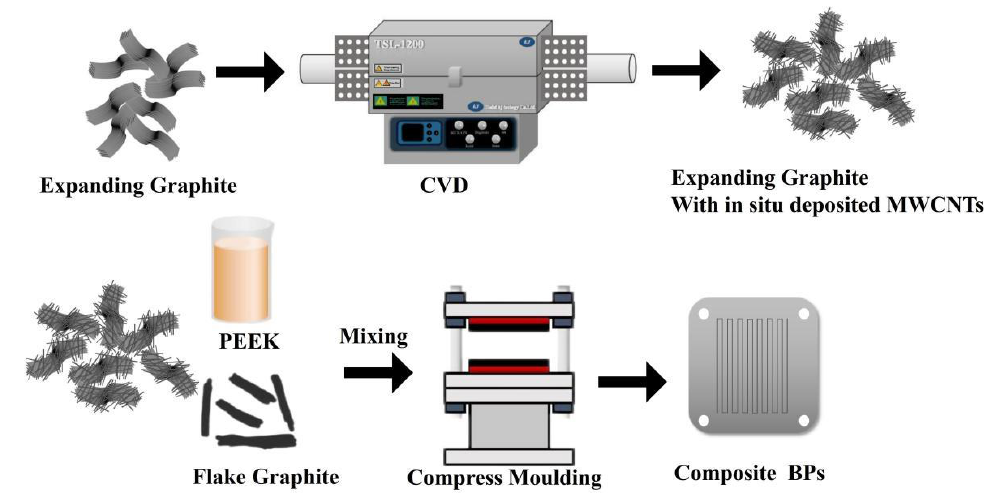
Figure 1. Schematic diagram of the preparation and structure of composite BPs.